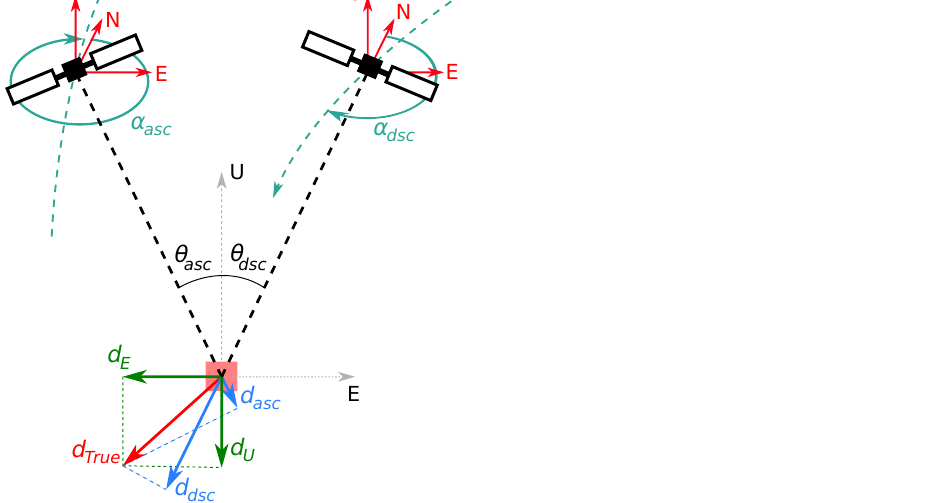
Figure 2. Geometry of a theoretical displacement vector d TRUE as seen by a SAR satellite in an ascending and descending pass,